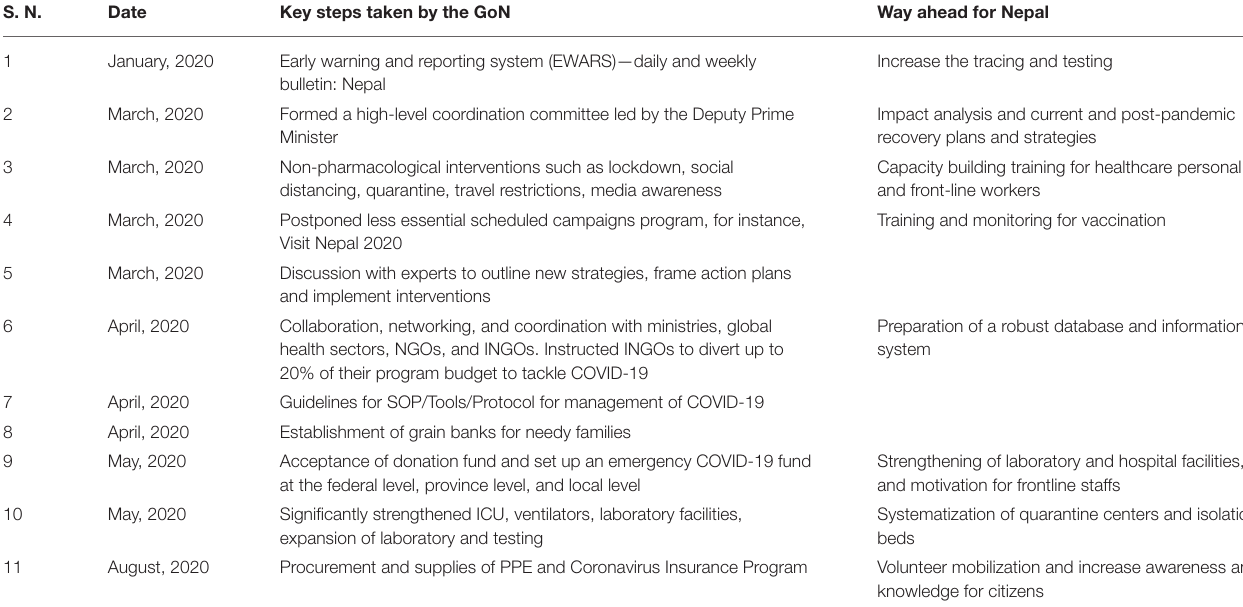
TABLE 4 | Major steps taken by GoN and way forward in the response to COVID-19 outbreak. S.